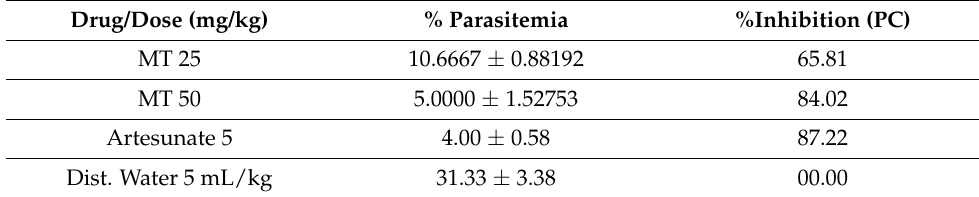
Table 8. Percentage of parasitemia